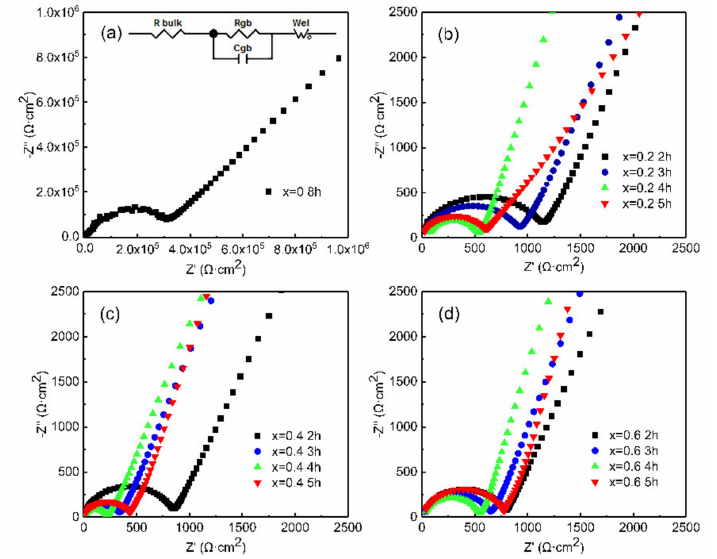
Figure 5. Nyquist plots of LLZN x O (x = 0, 0.2, 0.4, 0.6) ceramics at room temperature. ( a ) x = 0, ( b ) x = 0.2, ( c ) x = 0.4, ( d ) x = 0.6. R bulk , R gb ( C gb ), and W el in equivalent circuit are resistance of grain, resistance (capacitance) of grain boundary and Warburg impedance of electrode, respectively.